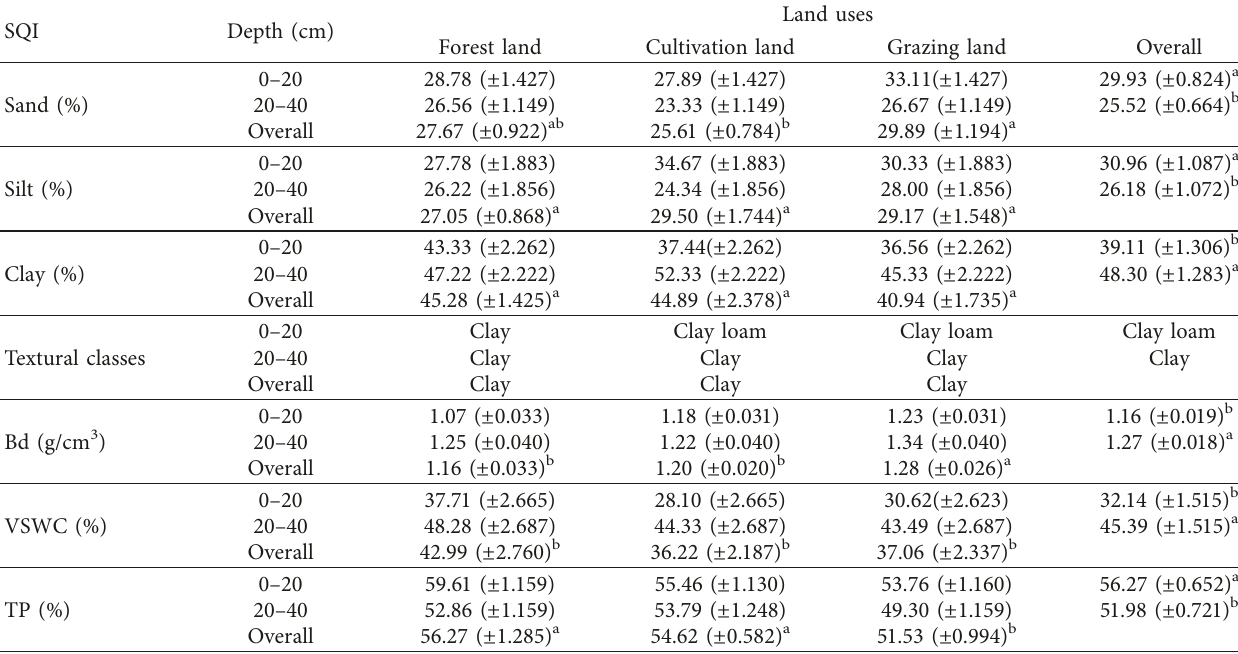
Table 2: Soil physical quality indicators in relation to the land use and soil depths (mean ± SE).